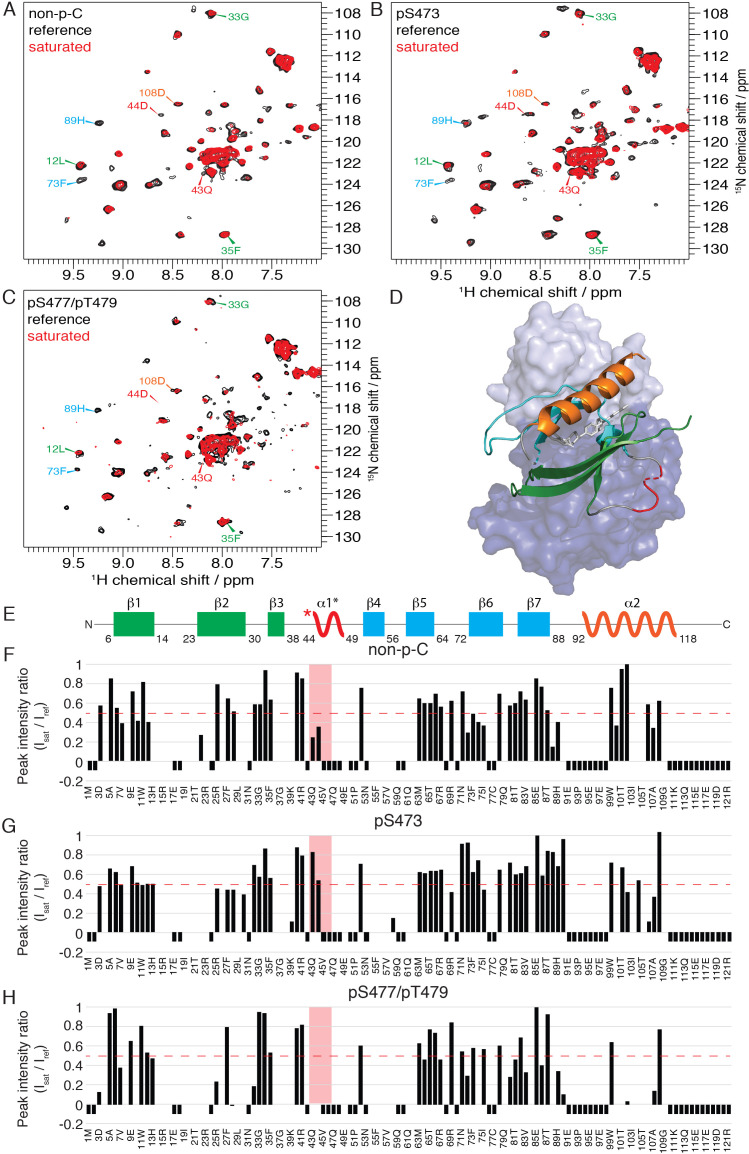
Cross-saturation transfer NMR analysis of the the PH-kinase domain interactions.(A–C) 15N-1H cross-saturation transfer spectra of the deuterated PH domain in the context of the semisynthetic full-length protonated Akt. Spectra where the kinase domain’s protons have been saturated are shown in red and their unsaturated reference in black for the non-phosphorylated C-tail (A), pSer473 (B) and pSer477/pThr479 (C) forms, respectively. Select residue-specific assignments are shown, color coded according to (E). (D) Structure of allosteric drug-inhibited Akt (PDB:3O96, [Wu et al., 2010]) with the PH domain as a ribbon cartoon on top and the kinase domain as a surface representation in the back. Color coding of secondary structure elements in the PH domain corresponds to (E). Allosteric inhibitor MK2206 is displayed in white. (E) Cartoon representation of secondary structure elements (rectangle for β-strands, zigzag for α-helices) in Akt PH domain. Color coding highlights regions with distinct binding modes to the kinase domain. Star indicates that the α-helix is present only when Akt is bound to IP4. (F–H) Saturation transfer efficiency derived from (A–C) plotted as the ratio of peak intensities of saturated over unsaturated spectra against the PH domain primary sequence for non-p (F), pSer473 (G) and pSer477/pThr479 (H) forms, respectively. A ratio of 0 indicates maximum saturation transfer efficiency, whereas a ratio of 1 indicate no saturation transfer. An indicative dashed red line has been drawn at 0.5. Red area highlights the short hinge primarily studied here. Negative ratios indicate non-assigned residues. Residues that were not present in 70% 2H2O have ratios set to 0.